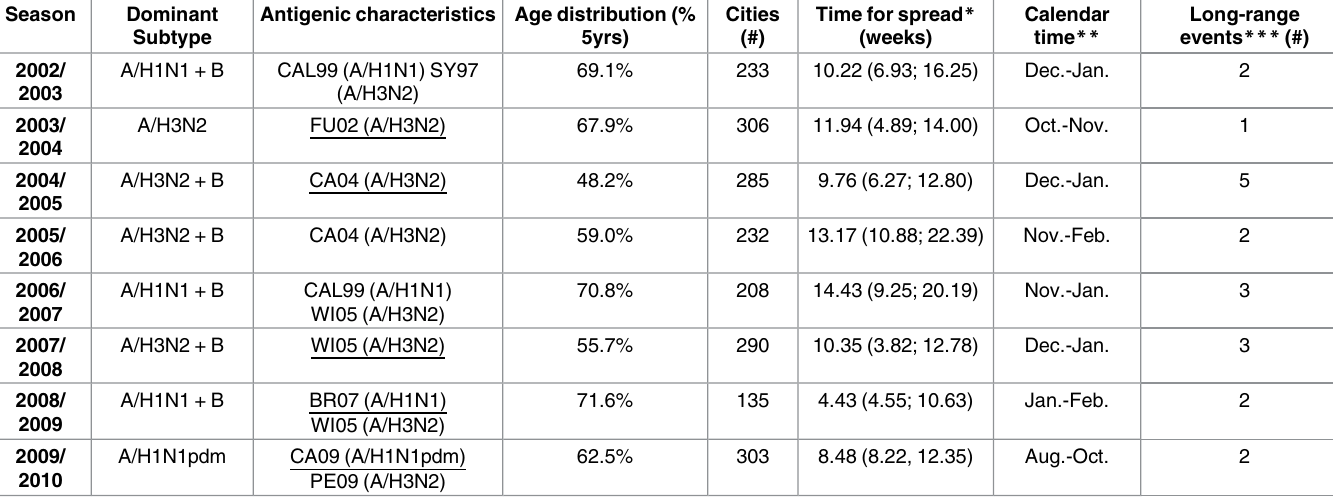
Table 1. Virological and epidemiological characteristics of US influenza epidemics,